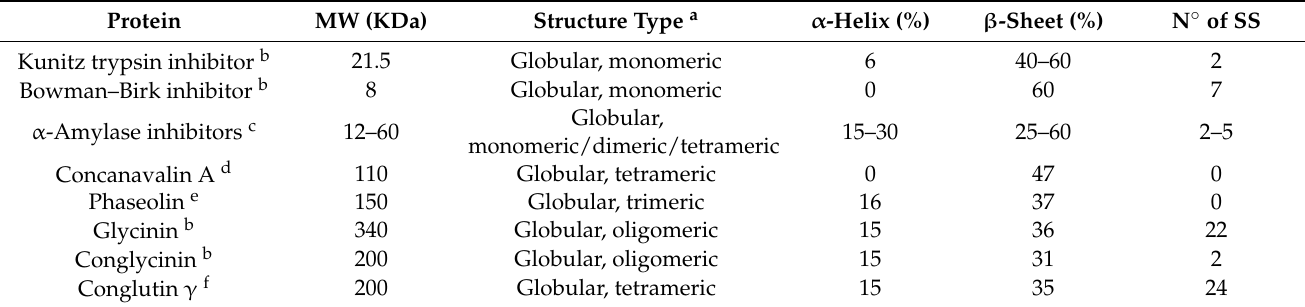
Table 2. Major structural properties of legume proteins with nutraceutical activity (modified from reference